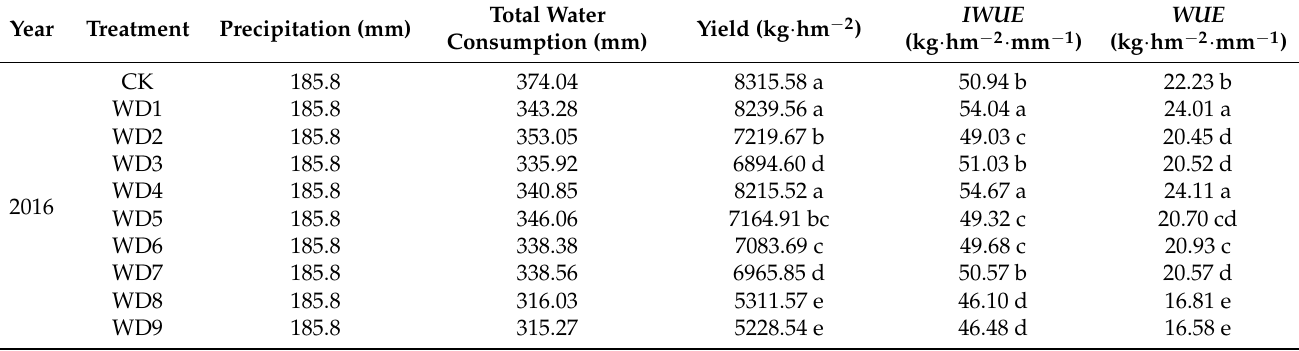
Table 3. Effects of different water deficits on the yield and water-use efficiency of Isatis indigotica